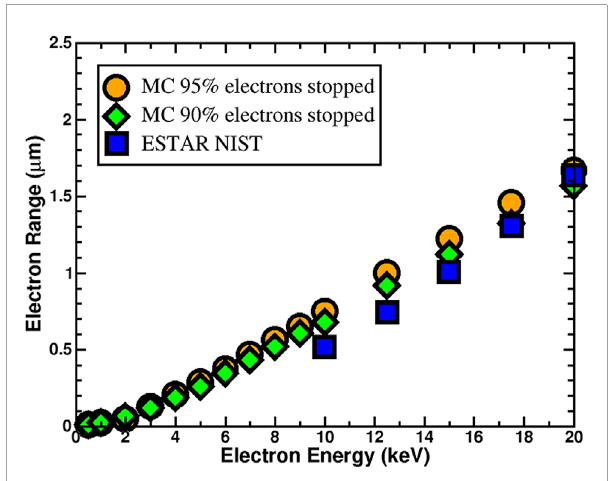
FIGURE 7 Electron range in clean Cu calculated from Monte Carlo simulations with lower limit of 90% (solid green diamonds) and upper limit of 95% (solid orange circles) of stopped electrons are compared with the ESTAR (blue solid squares) database provided by National Institute of Standards and Technology (NIST, 2022).